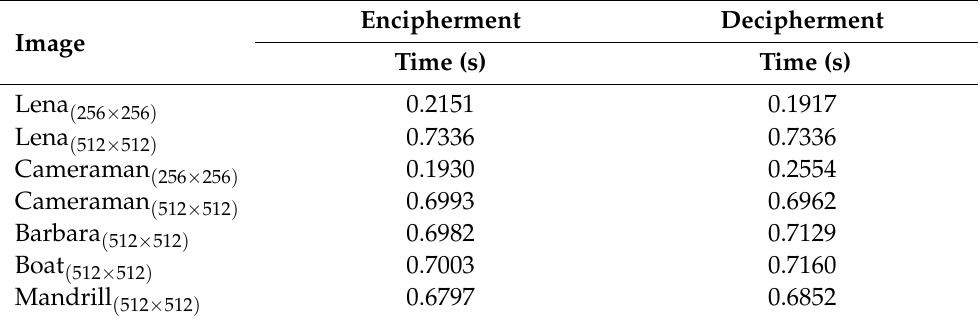
0.29, c 2 = 0.9, x 0 = 2.10, y 0 = − −